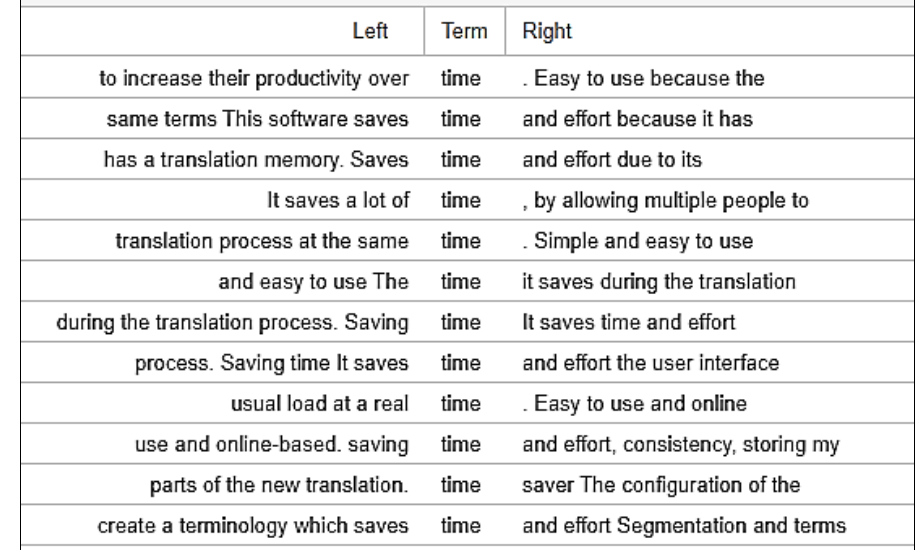
Figure 3. Most frequent words in participants’ responses on the best feature of CAT.